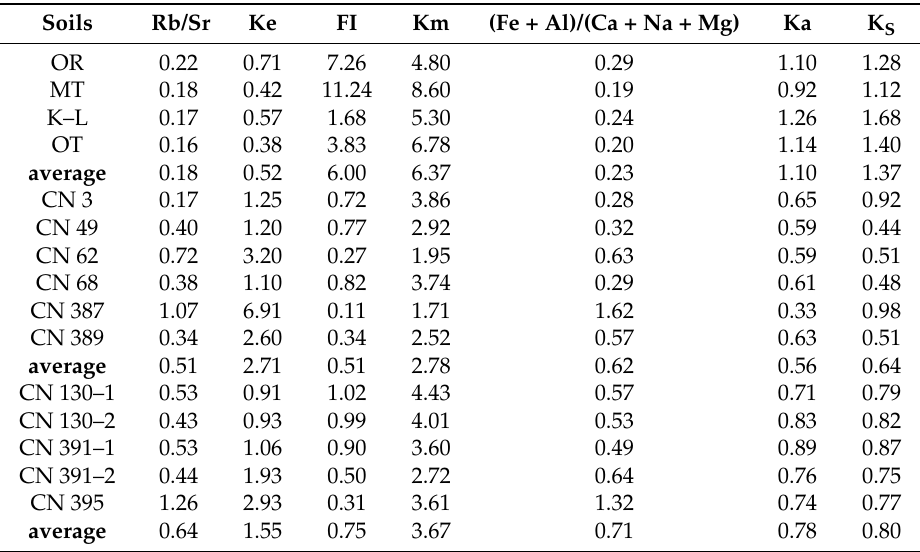
Table 2. The main geochemical indicators and their average values for soil groups.